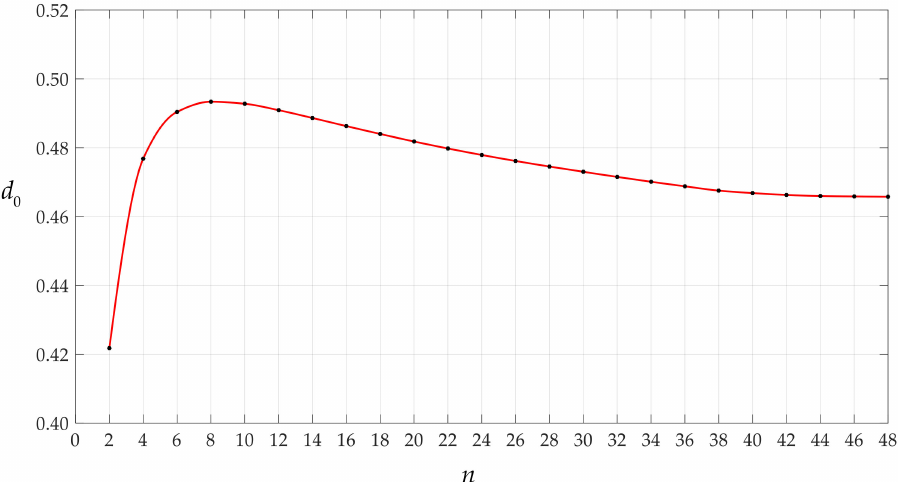
Figure 12. Variations of d 0 with n when q takes 0.0105